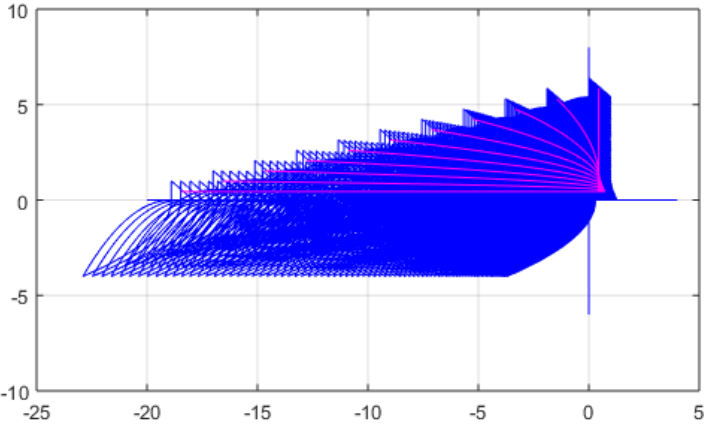
Figure 8. Payoff spaces and Nash trajectories for different values of β 1 and z ∈ [ 0,3 ]